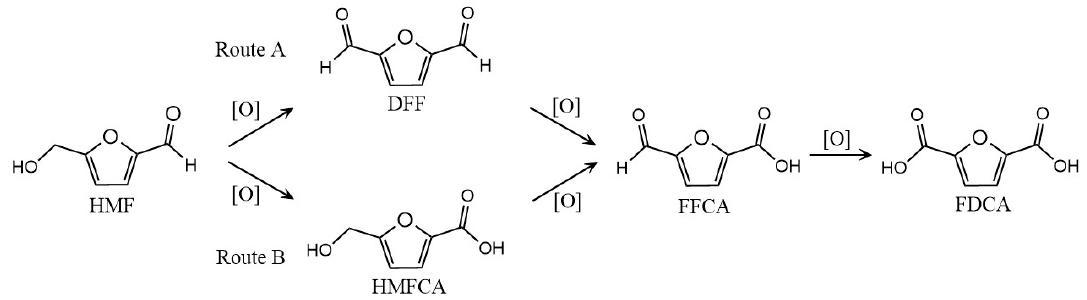
Figure 4. The potential pathway for FDCA production from HMF. McKenna et al. realized the enzymatic oxidation of HMF to FDCA using galactose oxidase M 3–5 (GO M 3–5 ) and aldehyde oxidase PaoABC through a one-pot reaction,